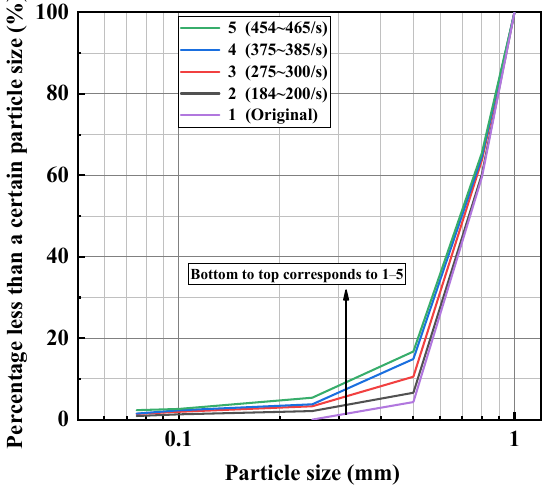
Figure 13. Grain distribution curves of sand specimens after impact loading .